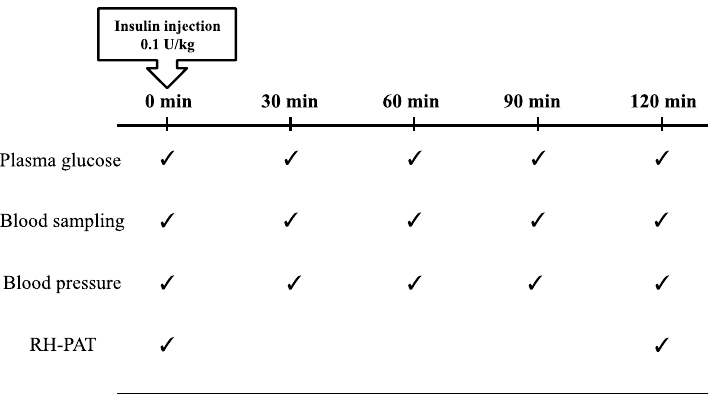
Figure 1. Study protocol. RH-PAT, reactive hyperemia peripheral arterial